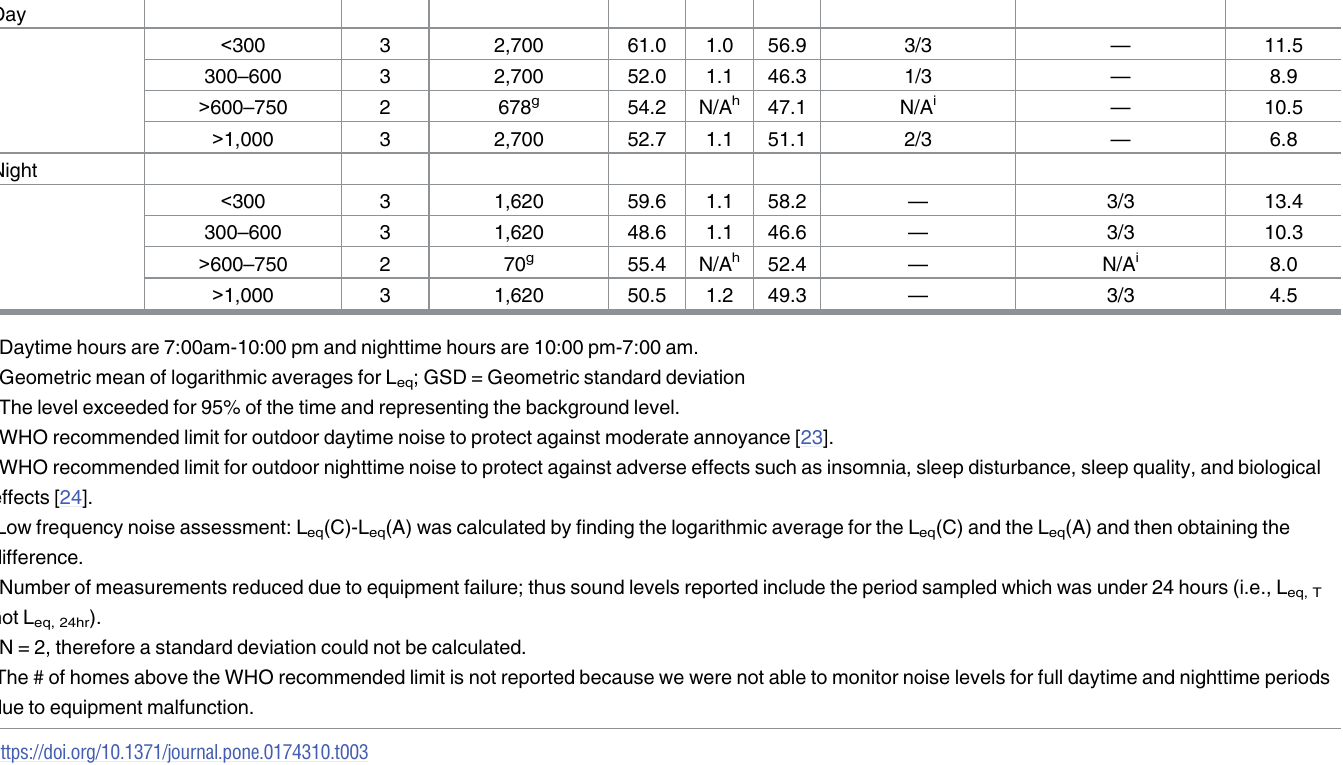
Table 3. Summarystatistics for A-weighted outdoor noise levels (dBA) stratified by distance and time of day. Time of day home